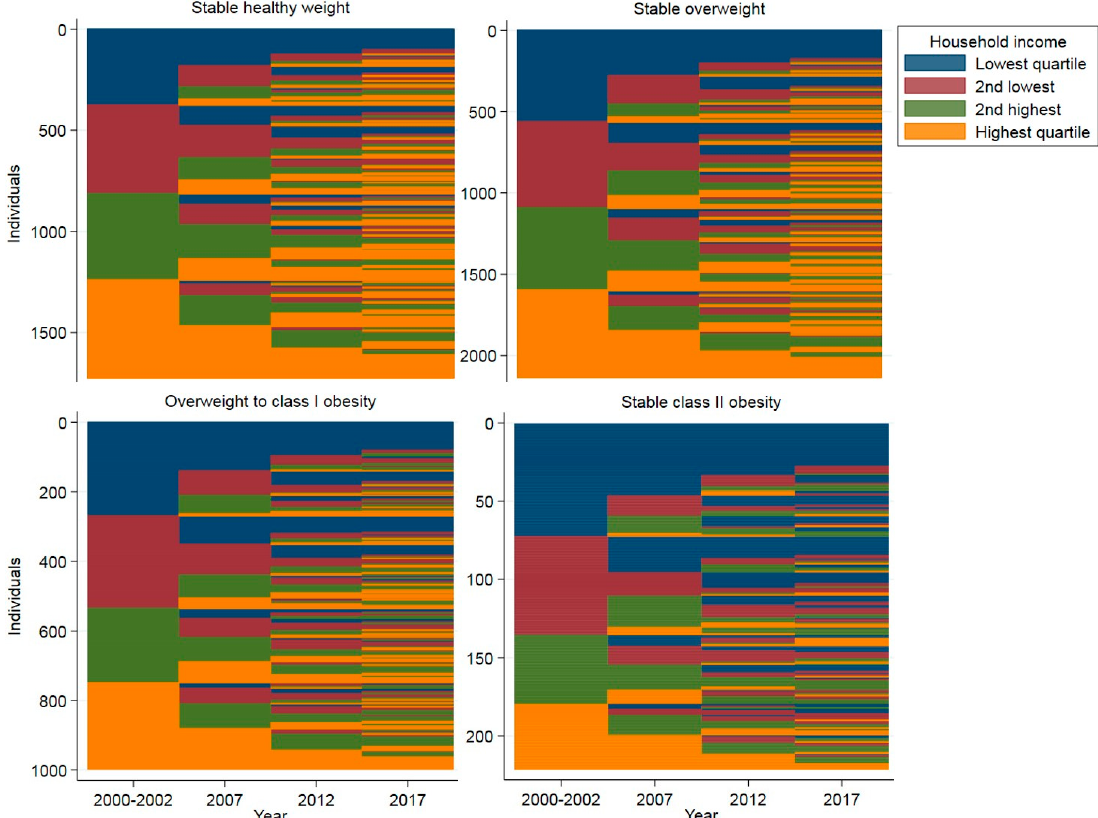
Figure 2. Sequence index plots of household income by the body mass index (BMI) trajectory groups: individual-level sequences in household income quartiles visualized over the follow-up. The y-axis includes all the individual observations within a BMI trajectory group, and the x-axis demonstrates the follow-up time. Each participant’s household income level sequence has been drawn in a horizontal line. Table 2. Characteristics of sequences in household income by the body mass index (BMI) trajectory groups over the follow-up (2000–2017).